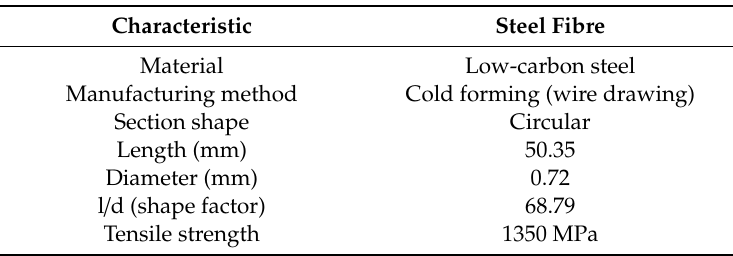
Table 1. Characteristics of steel fibres.